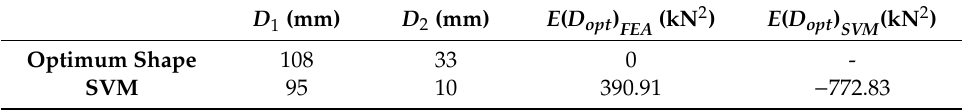
Table 2. The predefined and the support vector machines (SVM) model-based optimum